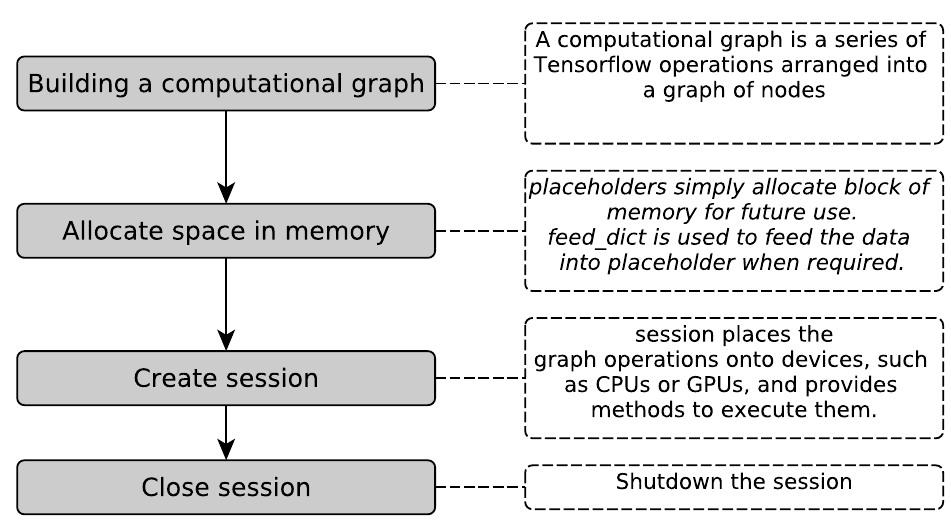
Figure 8. TensorFlow core program block